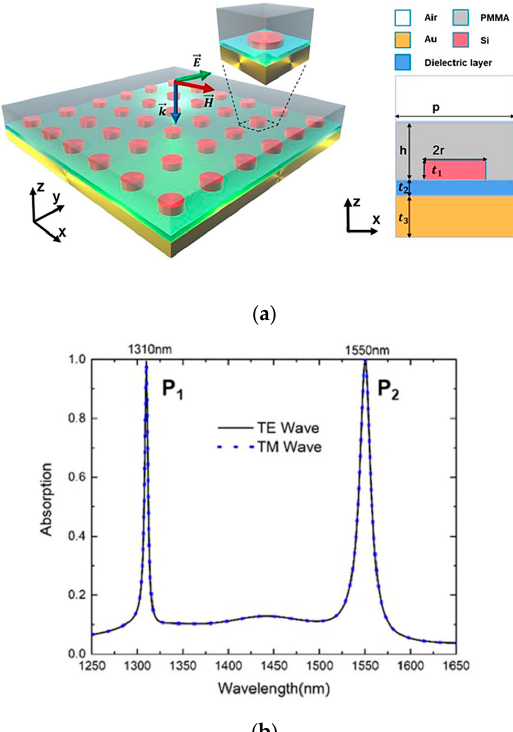
Figure 12. A dual-narrowband perfect metamaterial absorber suitable for optical communication band [50]. ( a ) The structure; ( b ) the curve of absorption.